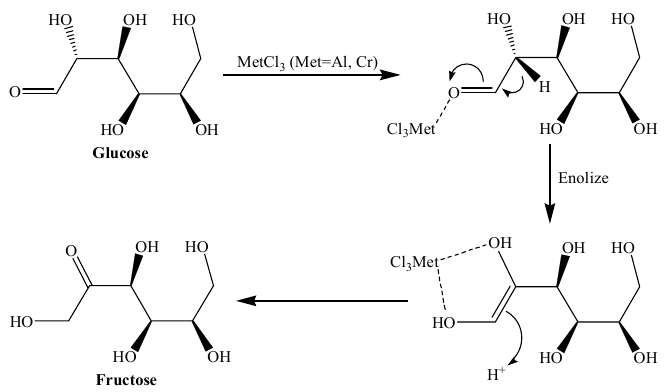
Scheme 2. Mechanism of glucose isomerization to fructose over metal